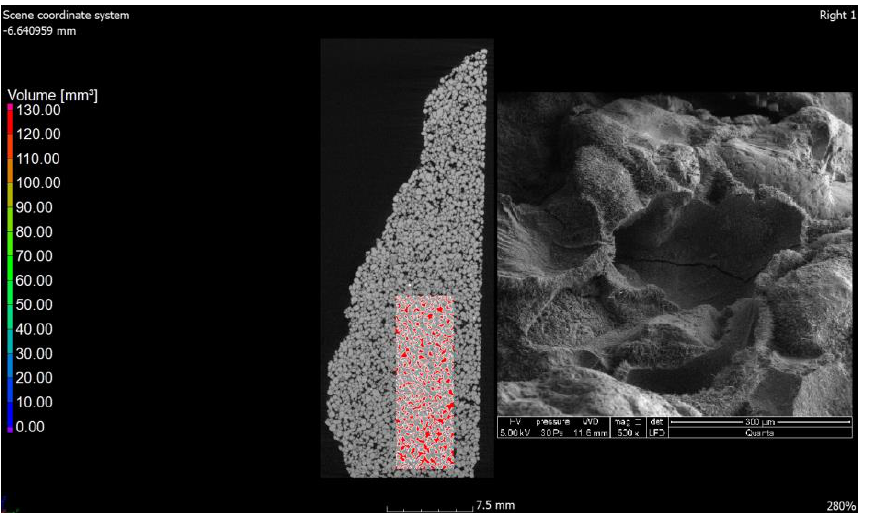
Figure 8. Cross-section through the reference material along with a photo from the scanning electron microscope; image 500×.